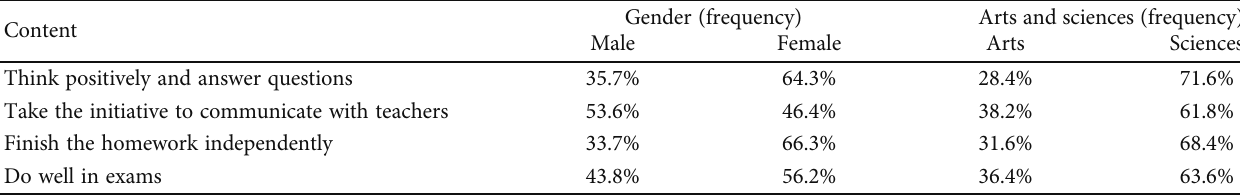
Table 4: Statistics of individual di ff erences among students.